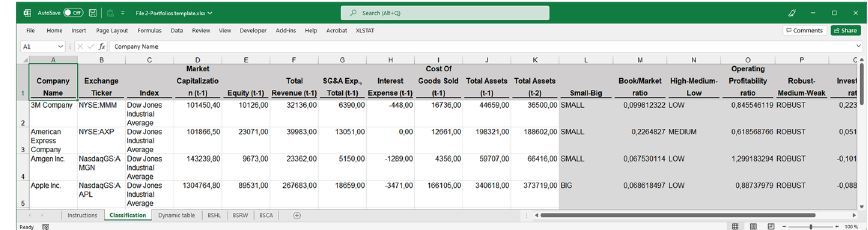
Fig. 5 Automatic spreadsheet template. Source : Created by